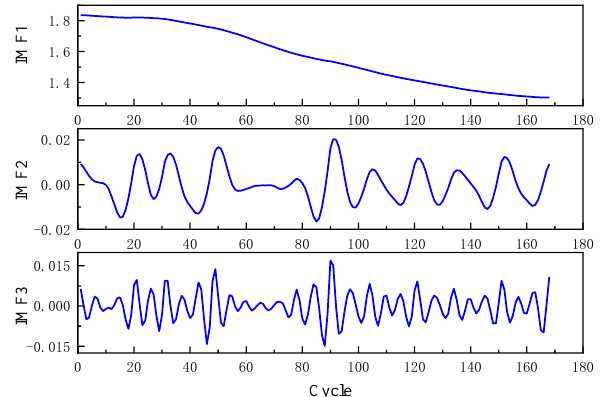
Figure 9. Decomposition effect when K = 3, α = 400.